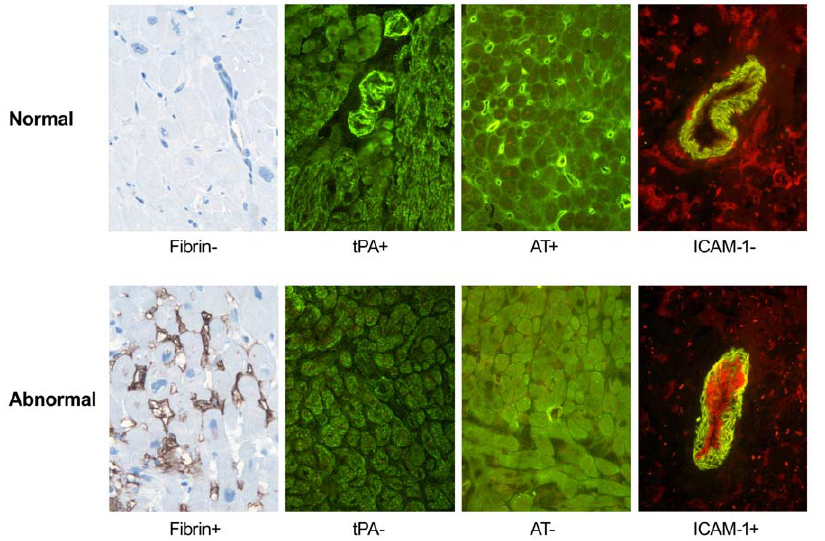
Figure 1. Immunohistochemical characteristics of a thrombotic/activated microvasculature. Normal hearts (top row) have absence of fibrin (Fib 2 ), presence of microvascular antithrombin (AT + ) and tissue plasminogen activator (tPA + ) and absence of arterial endothelial ICAM-1 (ICAM-1 2 ). Abnormal thrombotic and activated hearts (bottom row) are characterized by presence of fibrin (Fib + ), loss of microvascular antithrombin (AT 2 ) and tissue plasminogen activator (tPA 2 ) and expression of arterial endothelial ICAM-1 (ICAM-1 + ). Original magnification 6 640.